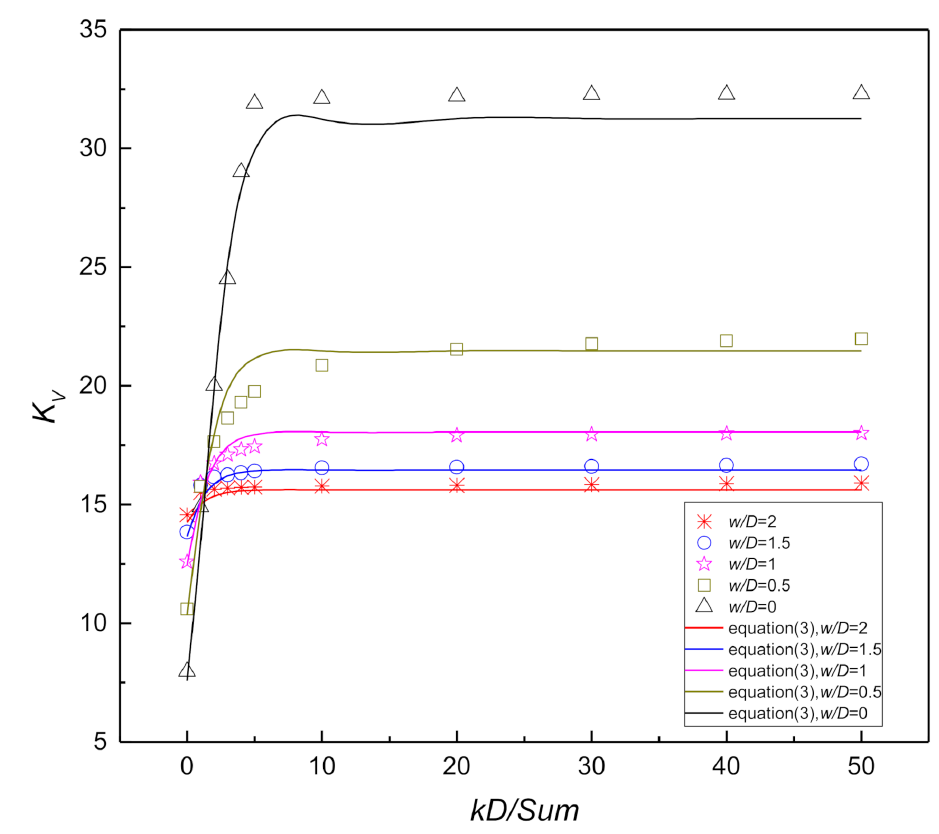
Figure 13. Vertical dimensionless elastic stiffness coefficients with complete backflow of